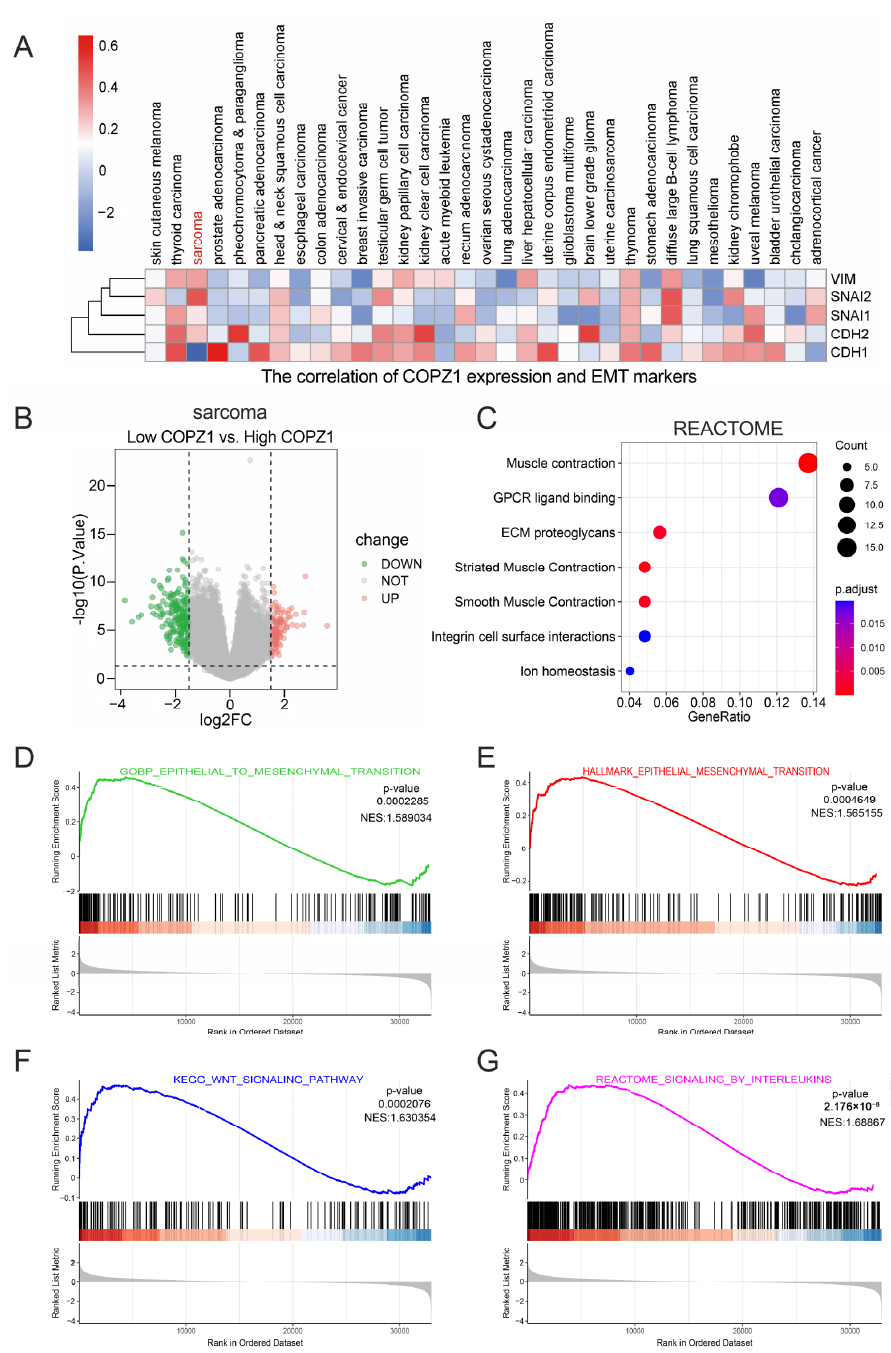
Figure 5. Correlation analysis of the COPZ1 expression and tumor metastasis. ( A ) Heatmap showed the correlation of COPZ1 expression and EMT related markers in 33 types of cancer. ( B ) The volcano plot of the DEGs between high and low COPZ1 expression in SARC. ( C ) The REACTOME enrichment analysis of the DEGs. ( D – G ) The GSEA enrichment analysis of the BP, HALLMARK, KEGG and REACTOME in SARC.